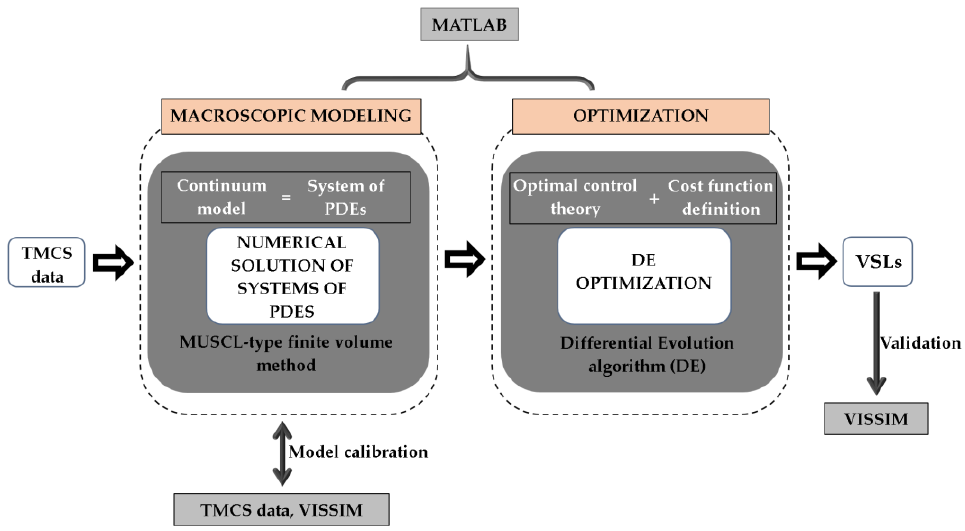
Figure 1. Methodological framework.